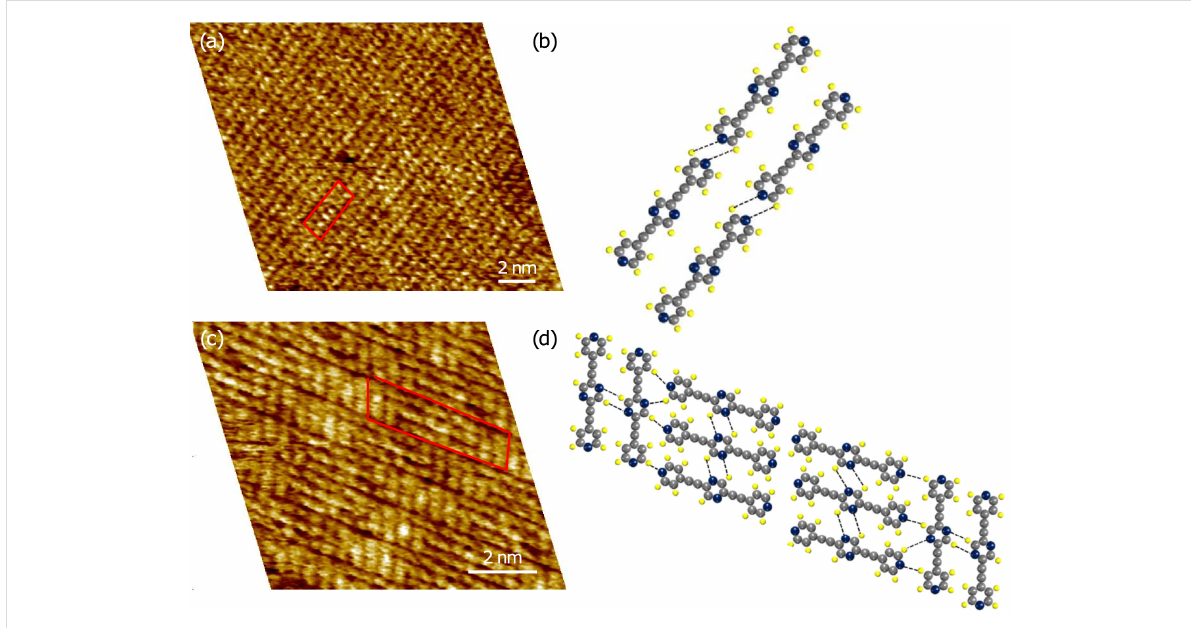
Figure 3: (a, c) Calibrated STM height images and (b, d) proposed molecular packing motifs of the corresponding polymorphs of 1 self-assembled at the solution–solid interface. Tunneling parameters: (a ,c) V s = 0.6 V, I t = 500 pA.